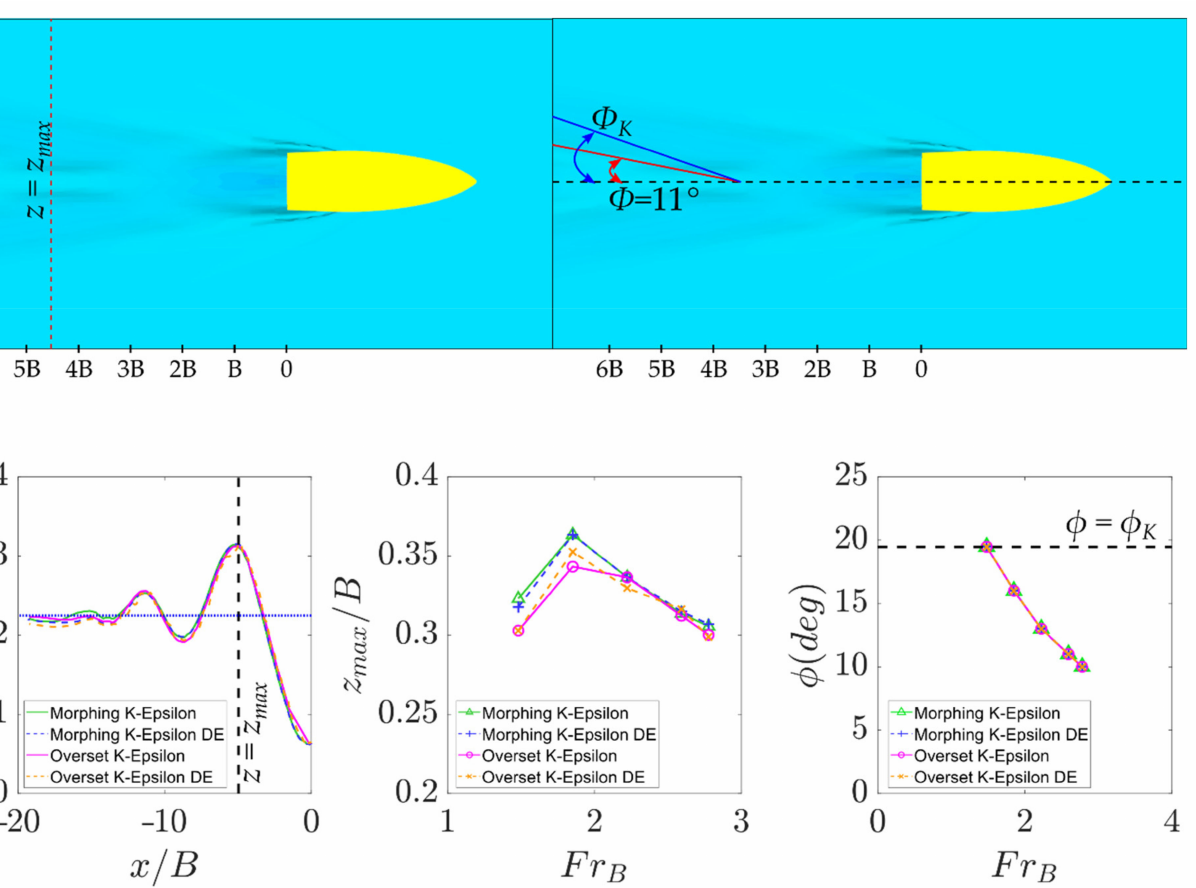
Figure 14. Details of the water surface around a planing hull. Wake angle, Kelvin angle as well as the maximum water height are shown in the upper panel. A samplse of the transom wave at beam Froude Number of 2.59, found using both different models is shown in the bottom left panel. Maximum water surface and wake angles are displayed in middle and right